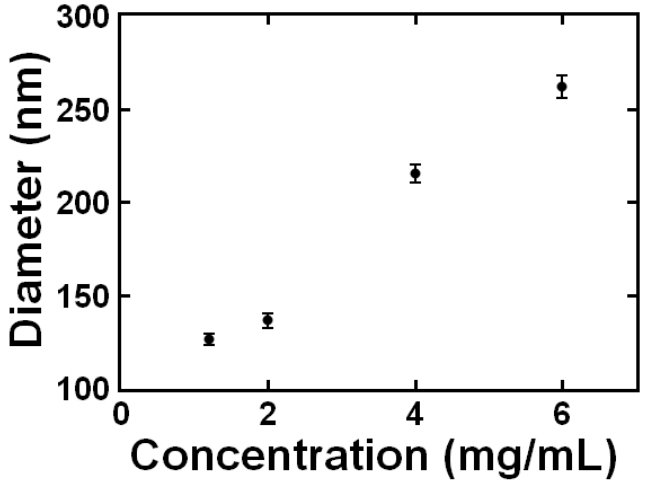
Figure 4. Tannic acid (TA)-chitosan nanoparticle size immediately following FNP as a function of total solids concentration (in the final dispersion). The mass ratio of TA to chitosan was 1:1; the mass ratio of block copolymer to core materials was 1:1; the solvent was water.